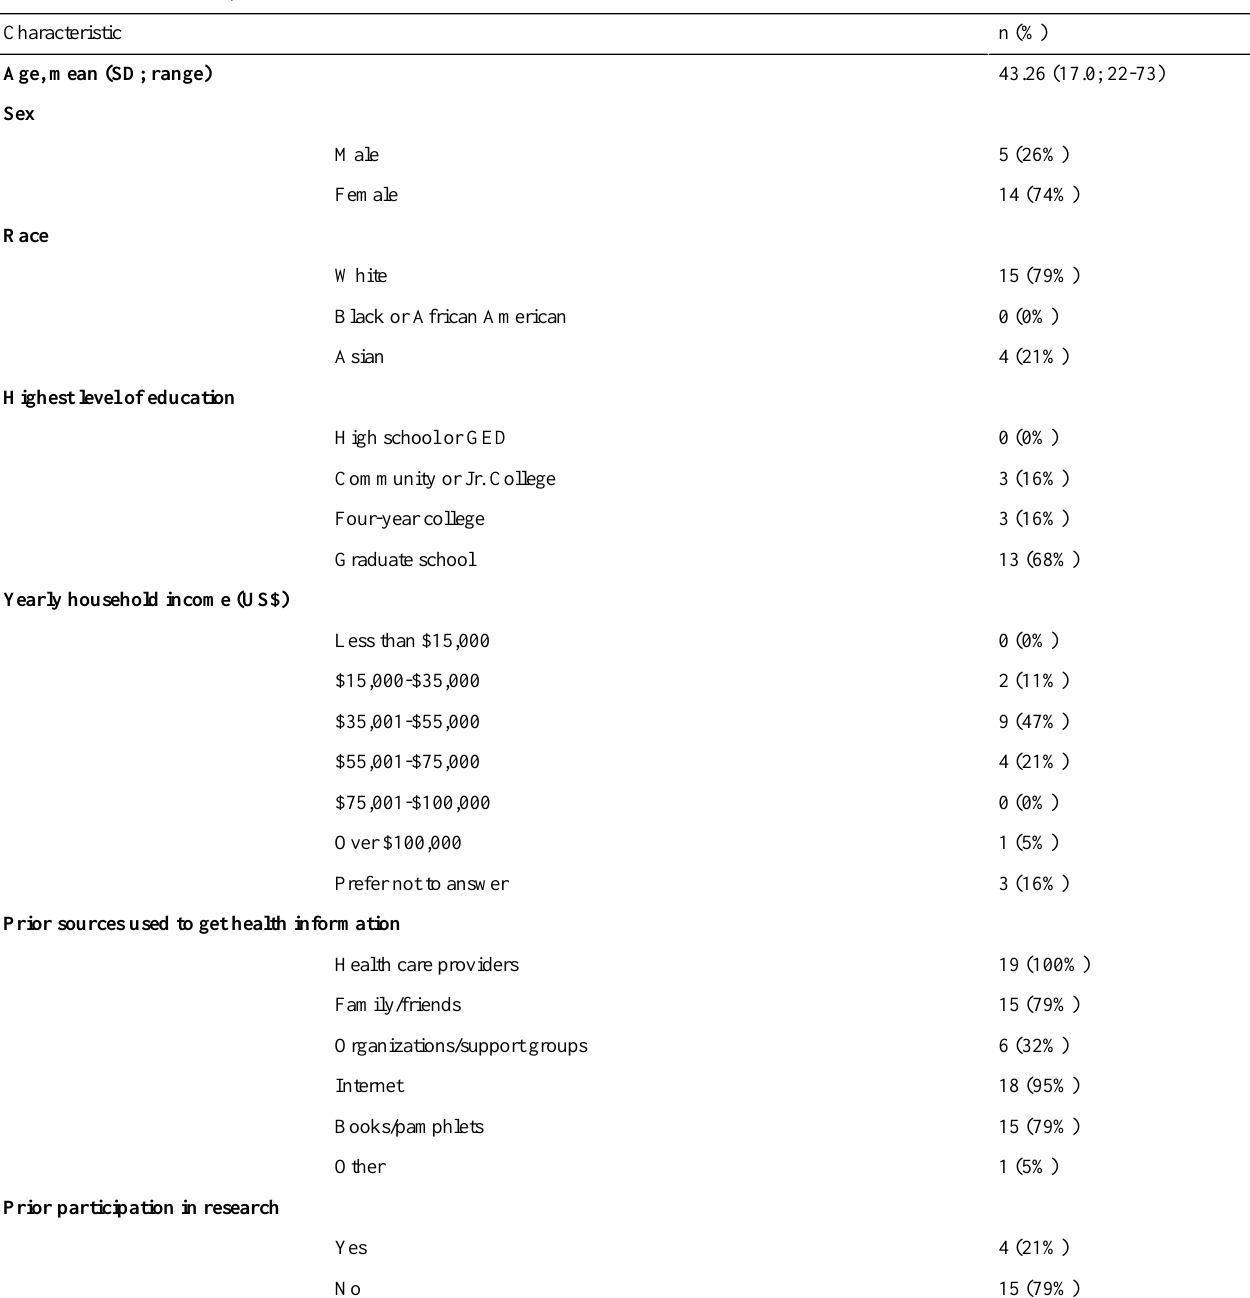
Table 1. Characteristics of patients